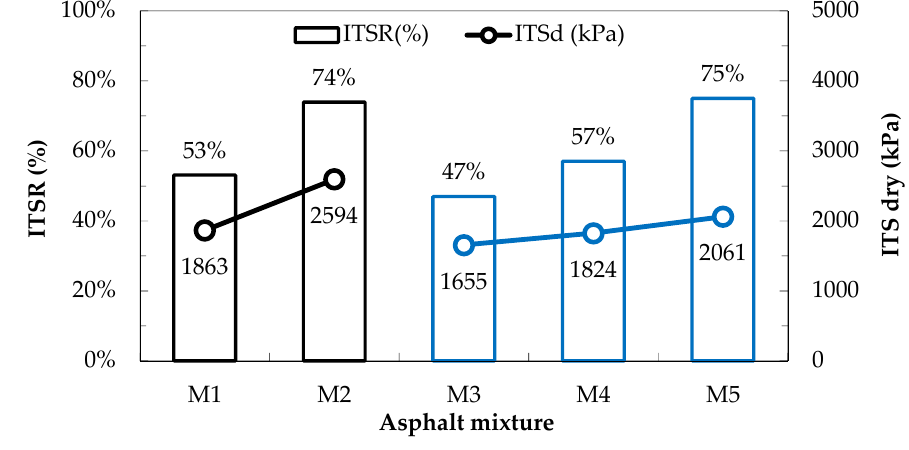
Figure 9. Water sensitivity test results of the studied mixtures.